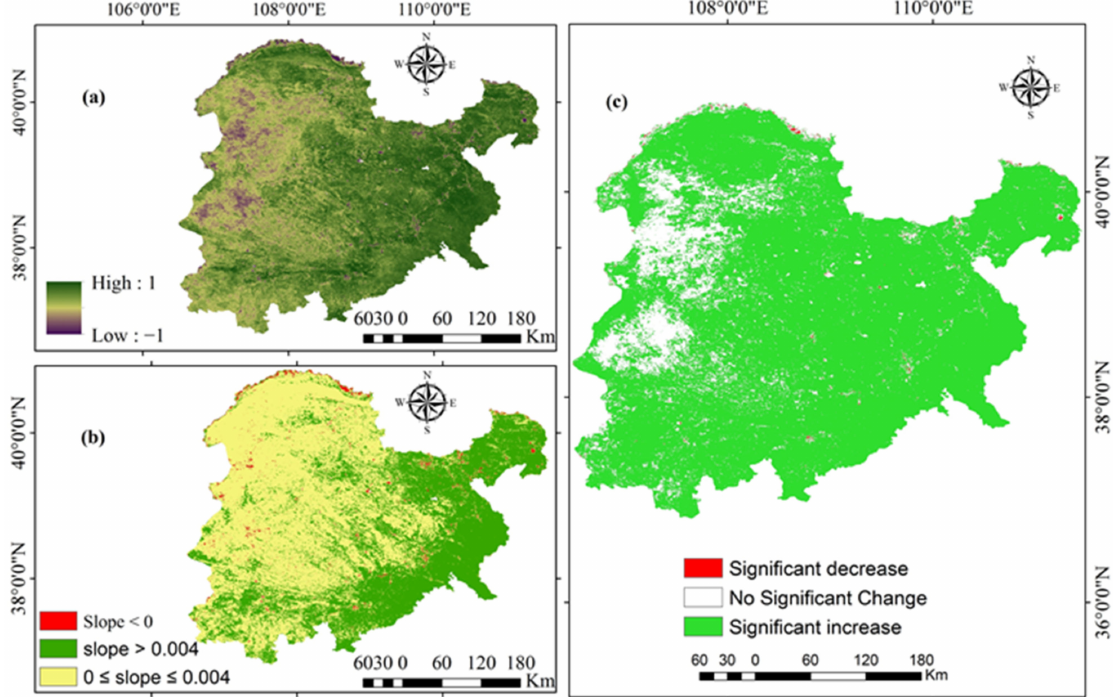
Figure 4. ( a ) MK trend test of MU US region from 2001–2018 ( b ) Classified Sen’s slope of annual NDVI of MU US region (1/year) ( c ) Trend significance of MU US region based on sen’s slop and MK-trend significance ( p <